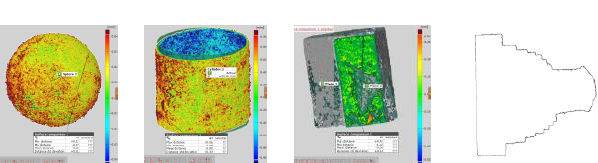
Table 4 - Accuracy for Fuji film FinePix Real 3D W3 sensor